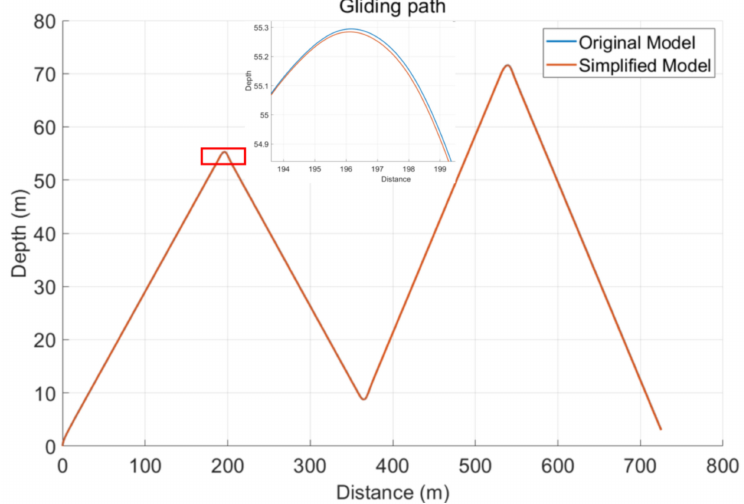
Figure 4. Glide path of original model and simplified